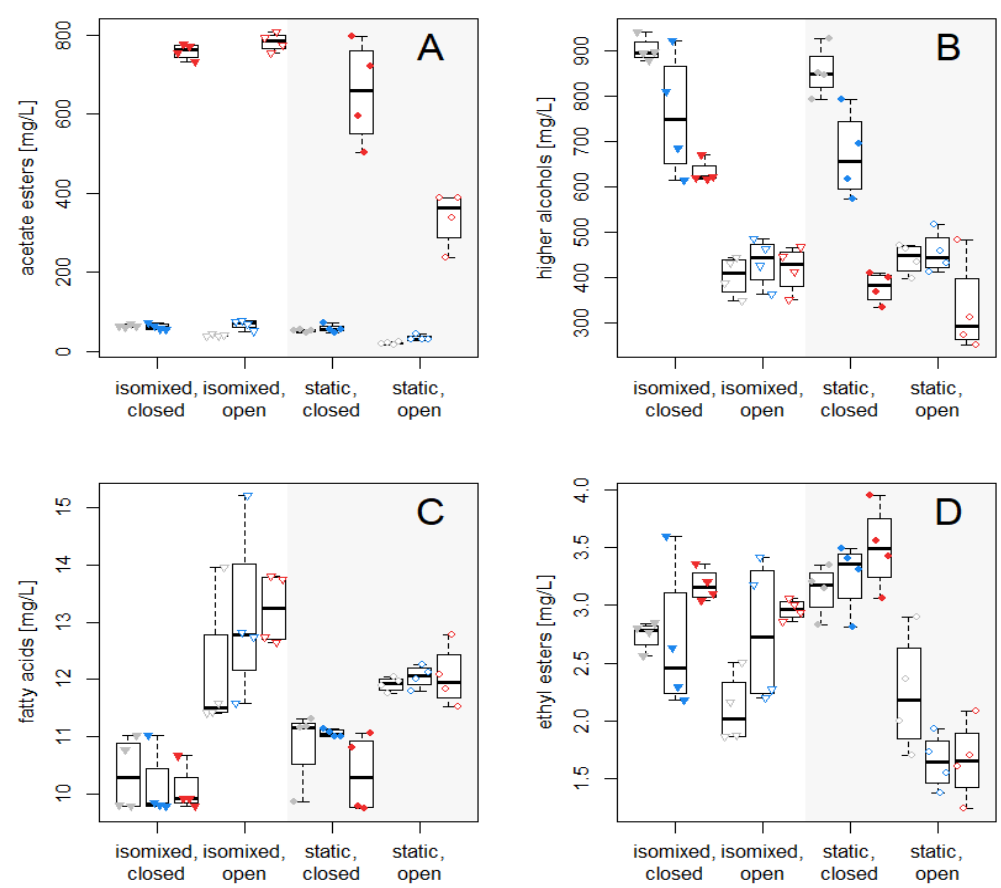
Figure 4. Effect of fermentation styles on the main groups of volatiles produced by the VIN13 strains. Box-and-Whiskers plots were drawn of the sum of the acetate esters ( A ), higher alcohols ( B ), fatty acids ( C ) and ethyl esters ( D ) measured in the final wines. Values of the individual components are shown in Table S3.